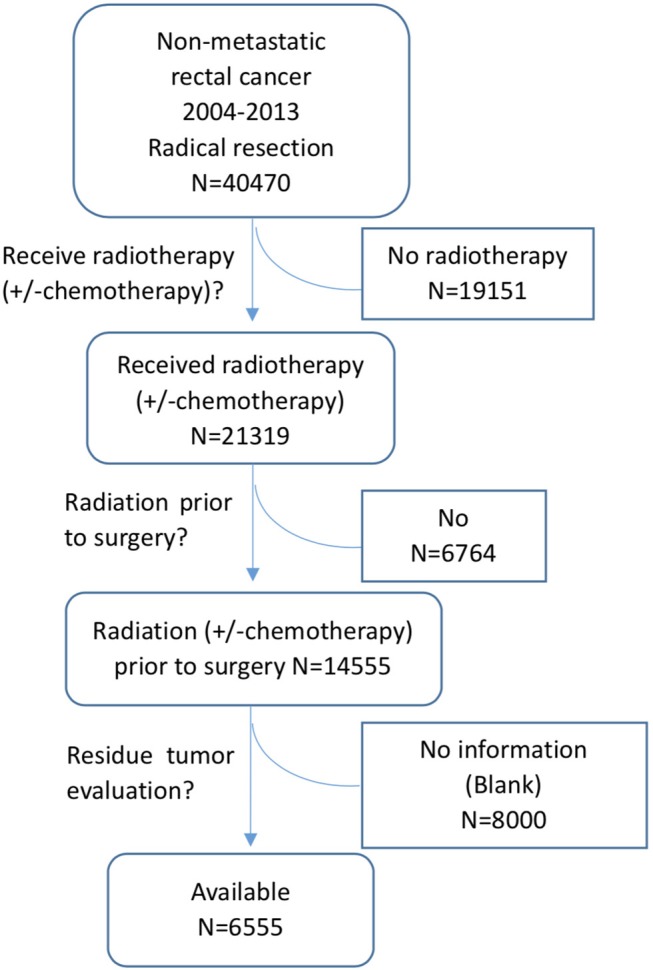
Filtering process of patient data from the SEER database.